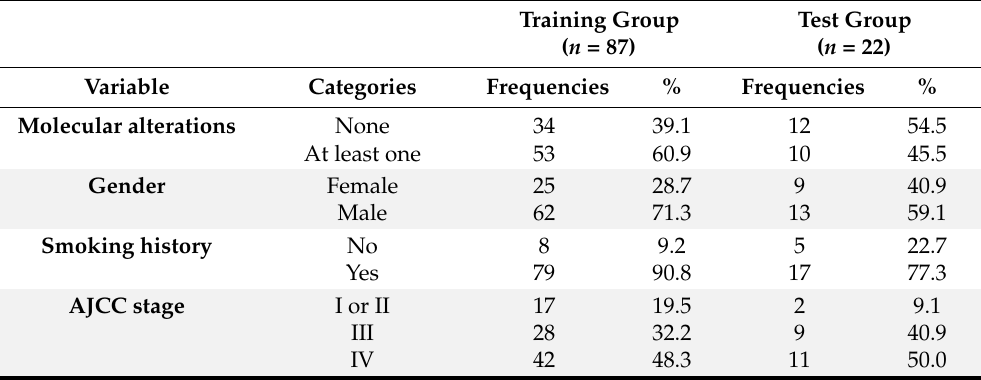
Table 1. Molecular and clinical characteristics of patients.